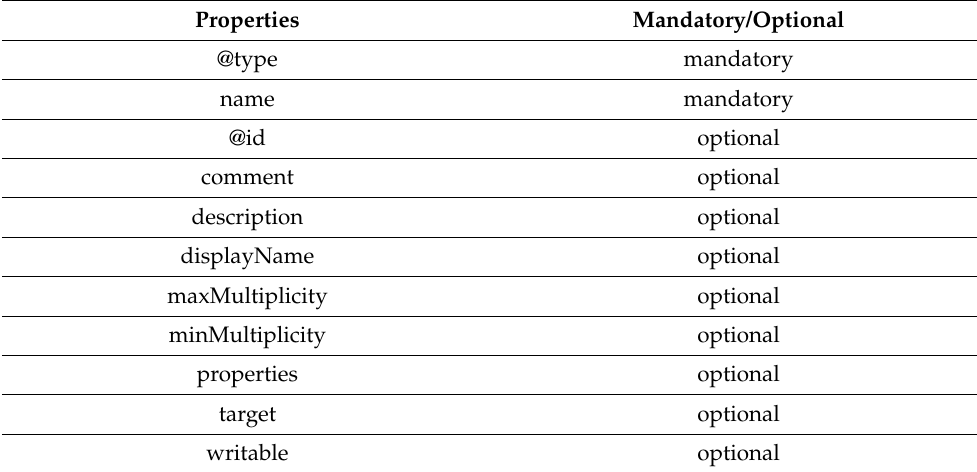
Table 11. Properties of the Relationship class.